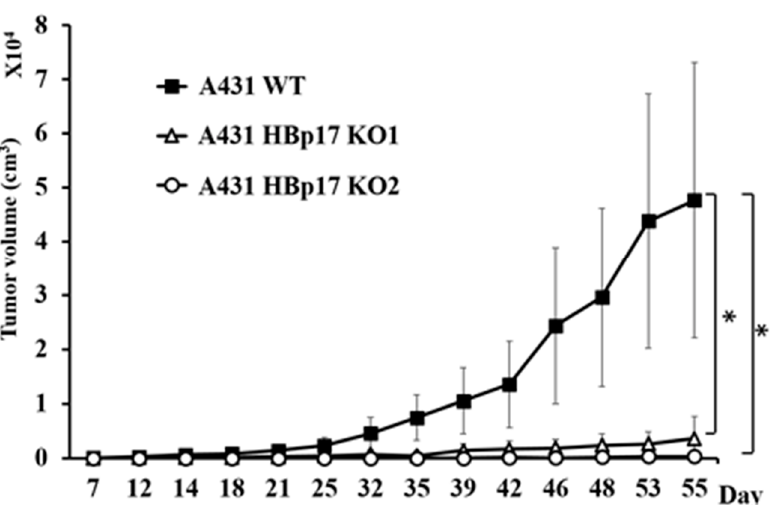
Figure 5. HBp17 knockout suppresses A431 tumor growth in immunodeficient mice. A431-HBp17- KO1, -KO2, and A431-WT cells were inoculated into the flanks of male nude mice, and tumor volume was measured twice a week. Experiments were performed with five mice. Data are presented as mean tumor volume + SD. * p < 0.05.